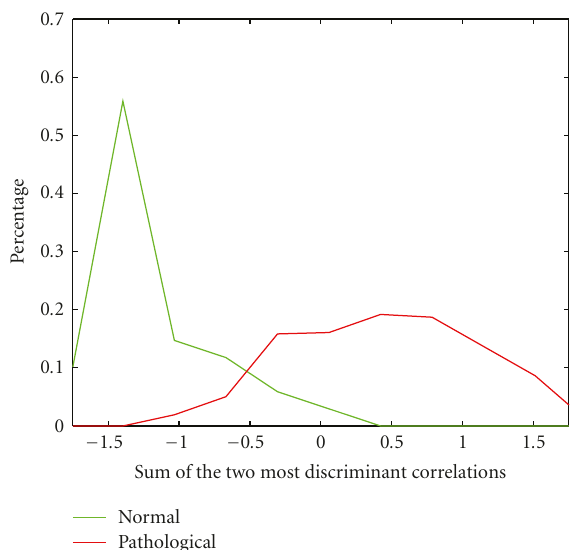
Figure 13: Distribution of the sum of the two most discriminative correlations for the two corpora of the training set (Normal: green; Pathological: